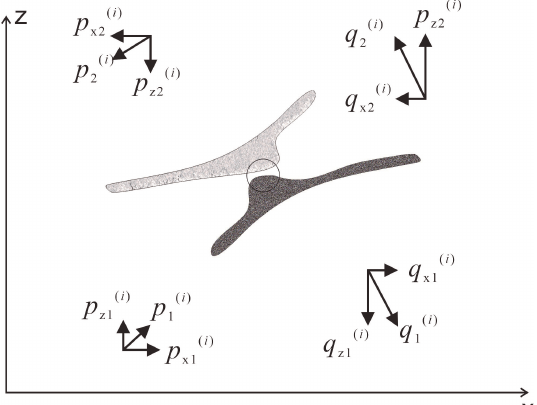
Figure 2. Force analysis of micro contacting surface; q , mechanical deformation resistance; p , molec- ular tangential resistance; q deformation resistance in z-direction; p lar tangential resistance in